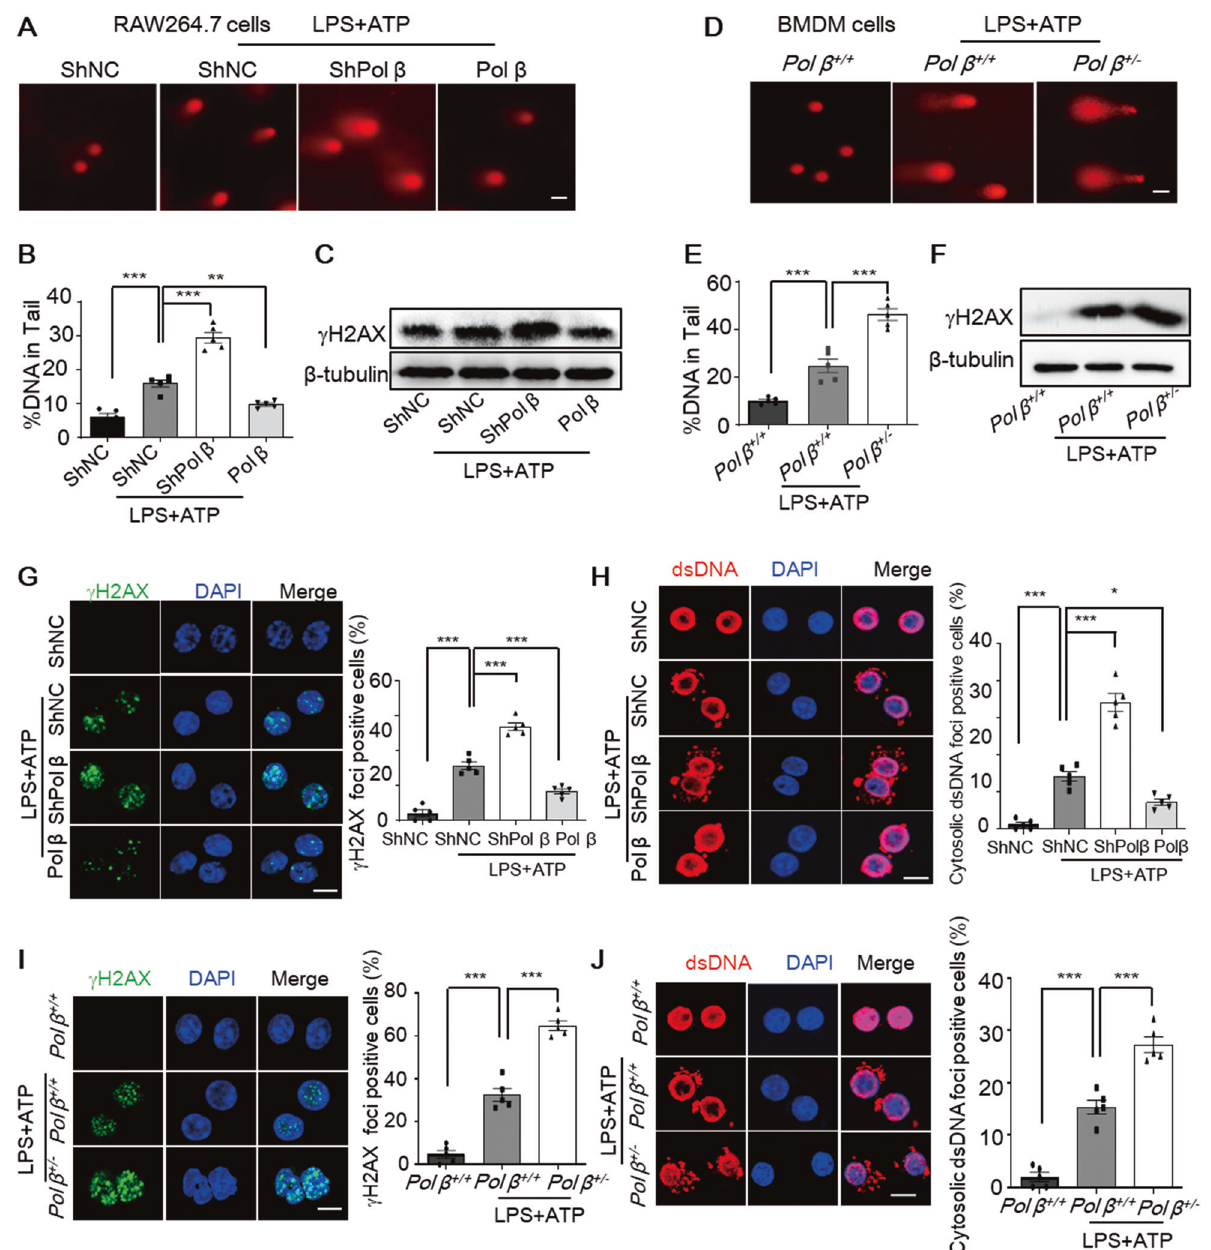
F Representative Western blot of γ -H2AX in BMDM cells after LPS plus ATP treatment. Representative immuno fl uorescence images of γ -H2AX and cytosolic dsDNA foci in RAW264.7 cells ( G , H ) and BMDM cells ( I , J ) after treatment with LPS plus ATP. Lower panel: statistical analysis, data represent the mean ± SEM of three independent experiments; * P < 0.05, *** P < 0.001, one-way ANOVA. Scale bar, 10 μ